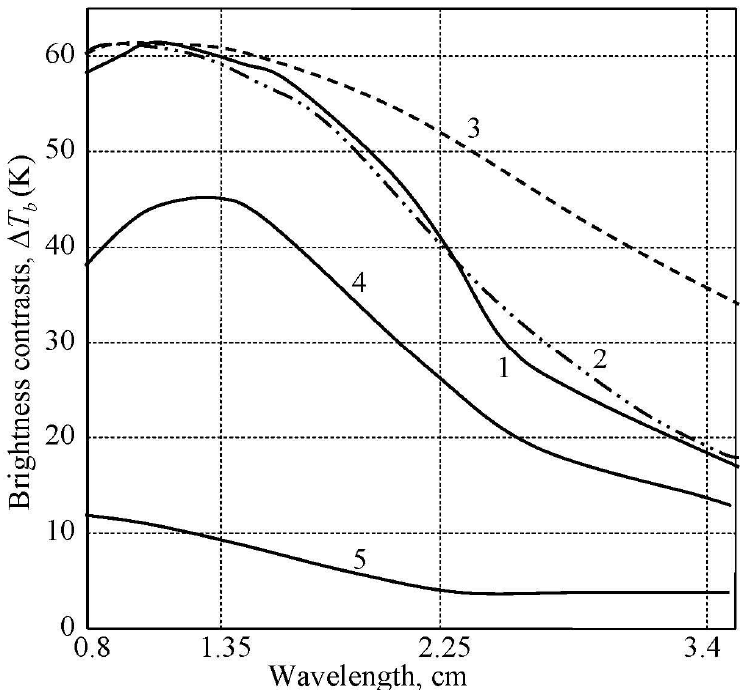
Figure 6. Typical brightness temperature distributions recorded along the IL-18 trace above the active fire pixels. The measurements were made on July 21, 1998 in the Irkutsk region, 75 km north of Irkutsk, a south-taiga forest. Numbers 1–5 identify forest fire zones: 1—smoky area, 2—fire front, 3— burning zone, 4—fire back and 5—forest.